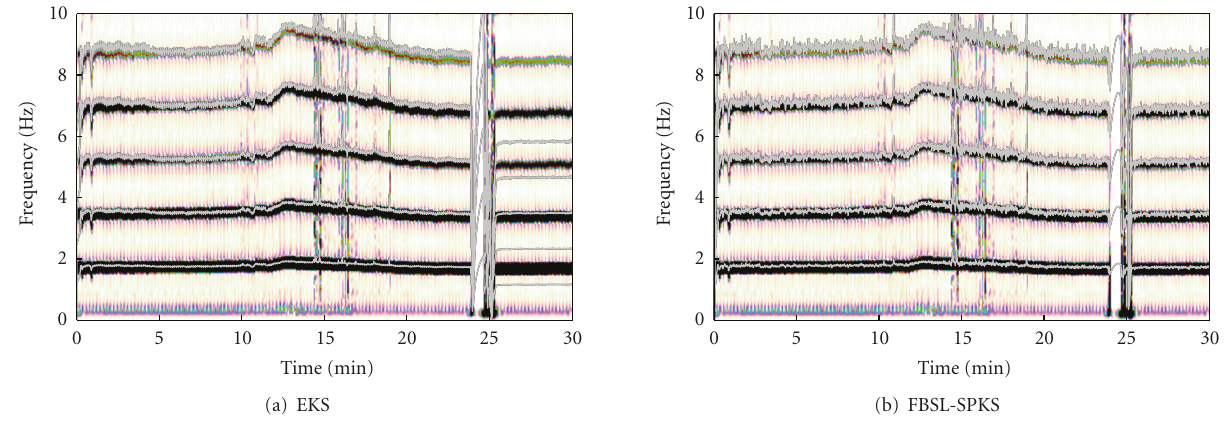
Figure 9: (a) Estimated frequency using the EKS on top of the spectrogram of an ABP signal. (b) Estimated frequency using the FBSL-SPKS on top of the spectrogram of an ABP signal.